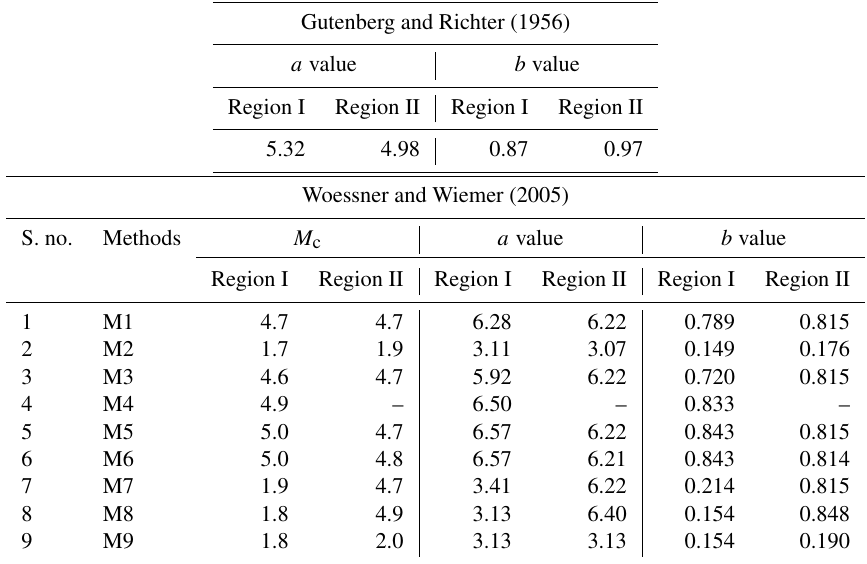
4 Selection of ground motion prediction